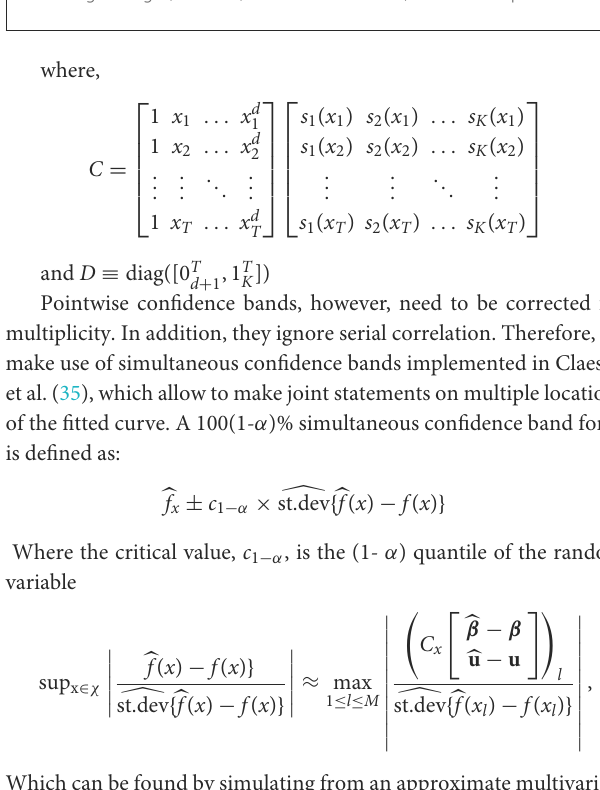
FIGURE4 Proportion of infection. Positive testing in South Africa. Observed positive testing rate over time, estimated positive testing rate (red line) and a 7 day moving average (blue line) between March 7th, 2020 and September 2nd,